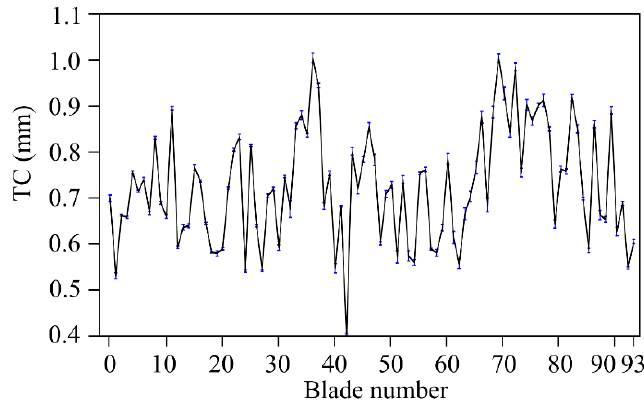
Figure 11. Tip clearance values of individual blades at 3627 rpm with error bars that account for the standard deviation over 20,000 revolutions.